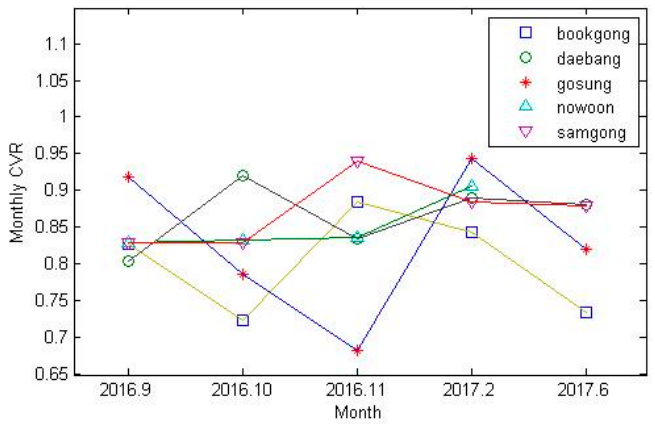
Figure 6. CVR factors of each D/L classified by season.